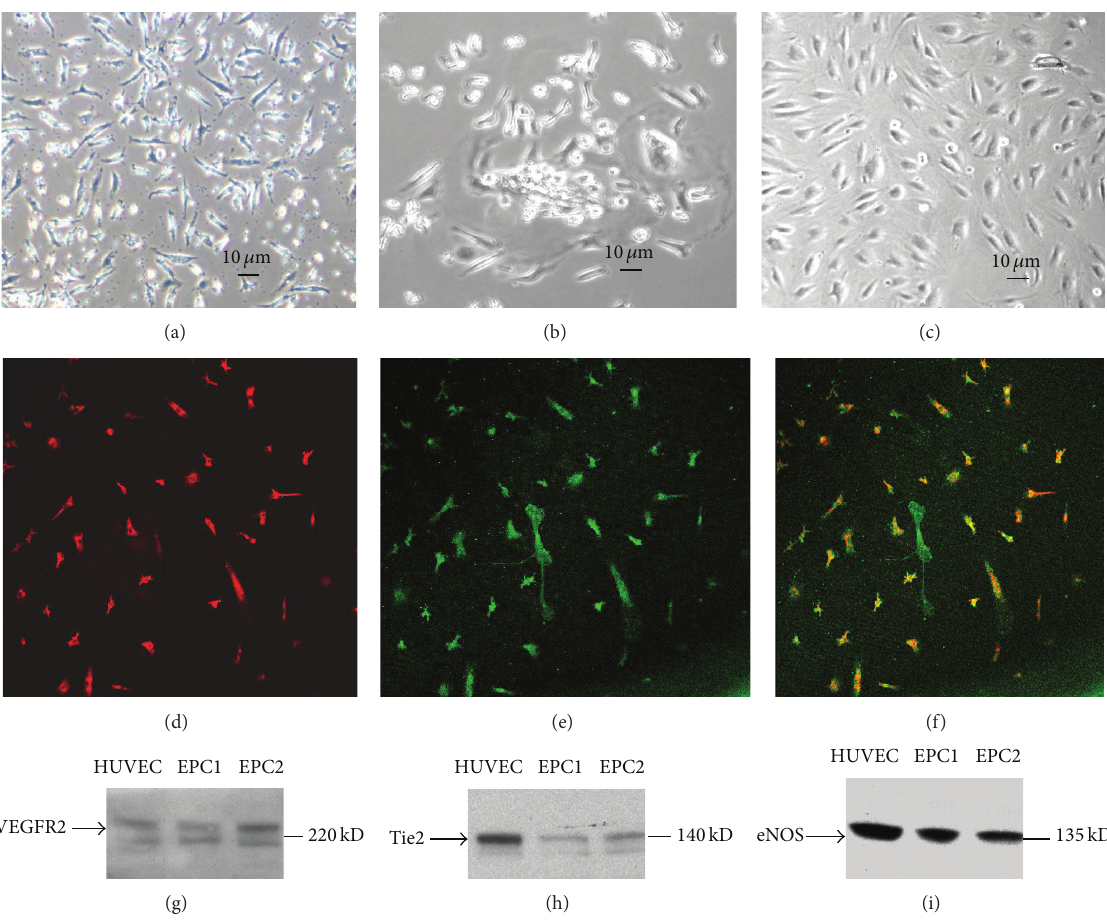
Figure1:CultureandcharacterizationofhumanEPCs.EPCsweregeneratedbycultureofPBMNCsinECgrowthmedium(EGM-2medium). Spindle-shaped early EPCs appeared in culture at days 4–7 (a). At around week 2, sporadic cell colonies formed (b), which were expanded to generate cobblestone-shaped late EPCs (c). Early EPCs were characterized by cell uptake of Dil-Ac-LDL ((d) red) and stain of FITC-UEA- lectin (e) green). Over 80% early EPCs were Dil-Ac-LDL/FITC-UEA-lectin double positive ((f) orange). Late EPCs expressed a series of EC protein markers, that is, VEGFR2 (g), Tie2 (h), and eNOS (i), as determined by western blotting. Human umbilical vein endothelial cells (HUVEC) were used as control for 2 isolations (EPC1 and EPC2) of late